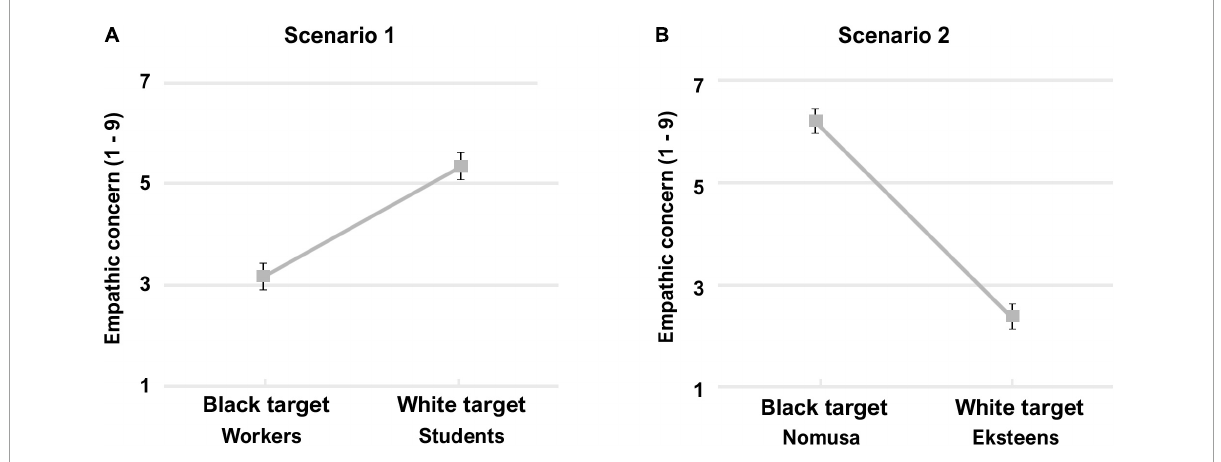
FIGURE3 Study 3 White participants’ self-reported empathic concern ratings for (A) scenario 1 (structural racism) and (B) scenario 2 (interpersonal injustice). Error bars indicate standard error of the mean.